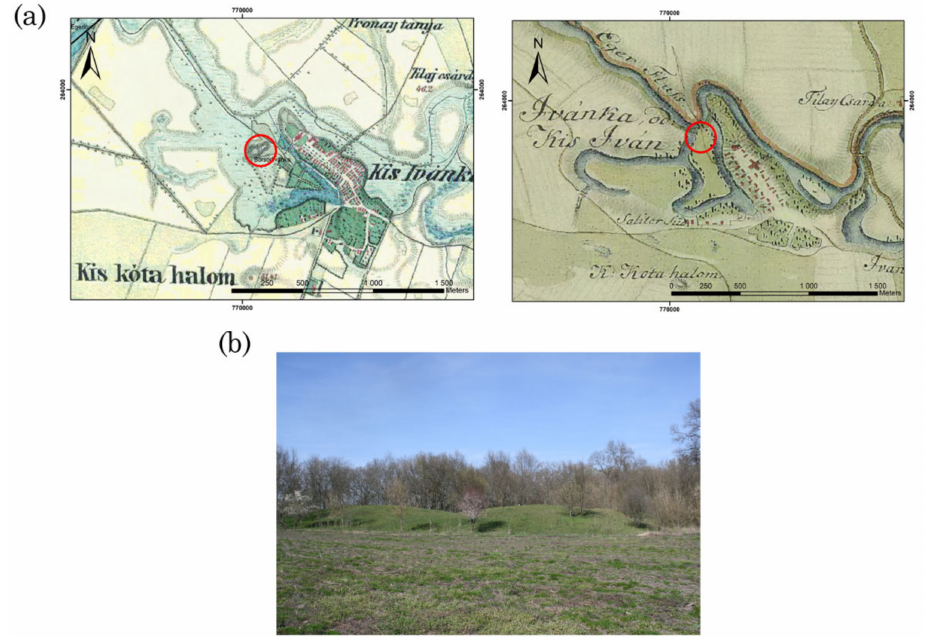
Figure 2. ( a ) The mound of Borsodiv á nka-Marhaj á r á s-Nagyhalom, surrounded by water, on the old Austrian–Hungarian maps of the First and Second Military Surveys (1806–1869). ( b ) Borsodiv á nka- Marhaj á r á s. The tell part of the site seen from the south-east with surface survey in progress on the surrounding outer settlement [1]. The red cicle indicate the location of the site of Borsodiv á